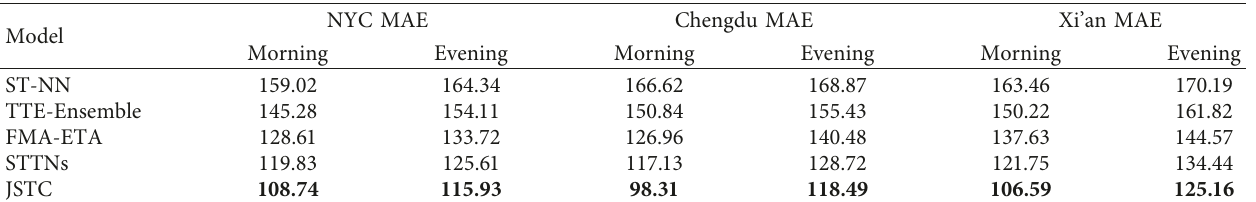
Table 5: An illustration of all models’ performances with morning and evening peak periods (MAE) for NYC, Chengdu, and Xi’an. NYC MAE Model Morning ST-NN TTE-Ensemble